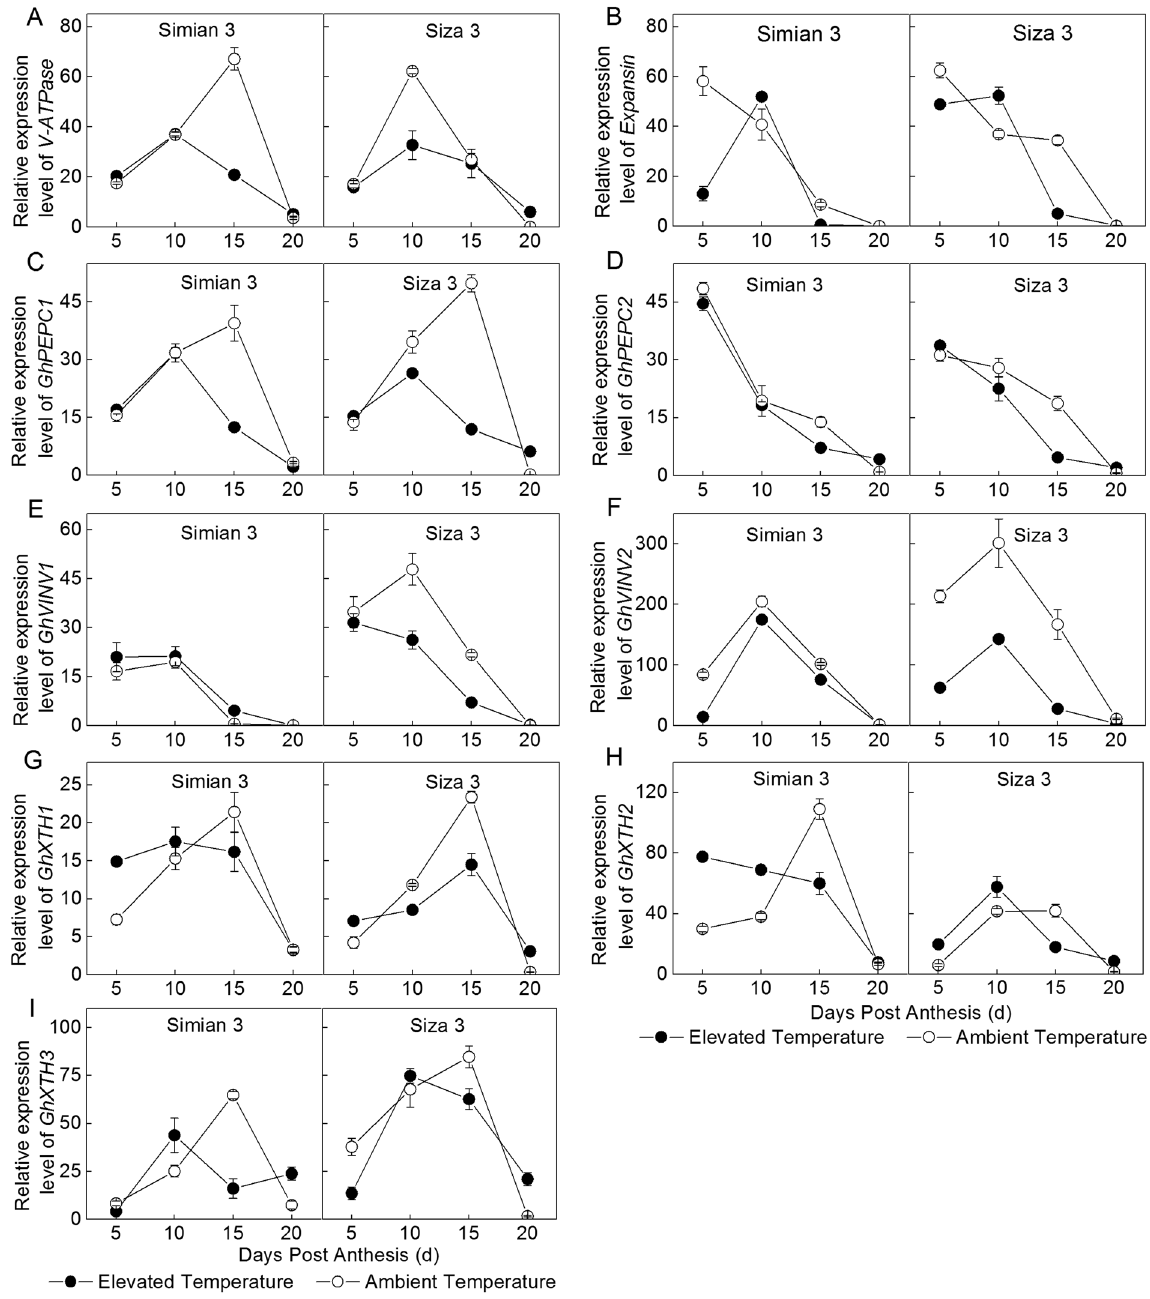
Figure 6. Relative expression quantities of key genes engaged in cotton fiber development in two temperature regimes, in 2012. V-ATPase ( A ), Expansin ( B ), GhPEPC1 ( C ), GhPEPC2 ( D ), GhVINV1 ( E ), GhVINV2 ( F ), GhXTH1 ( G ), GhXTH2 ( H ), GhXTH3 ( I ). Each data point represents the mean ± SE of three biological